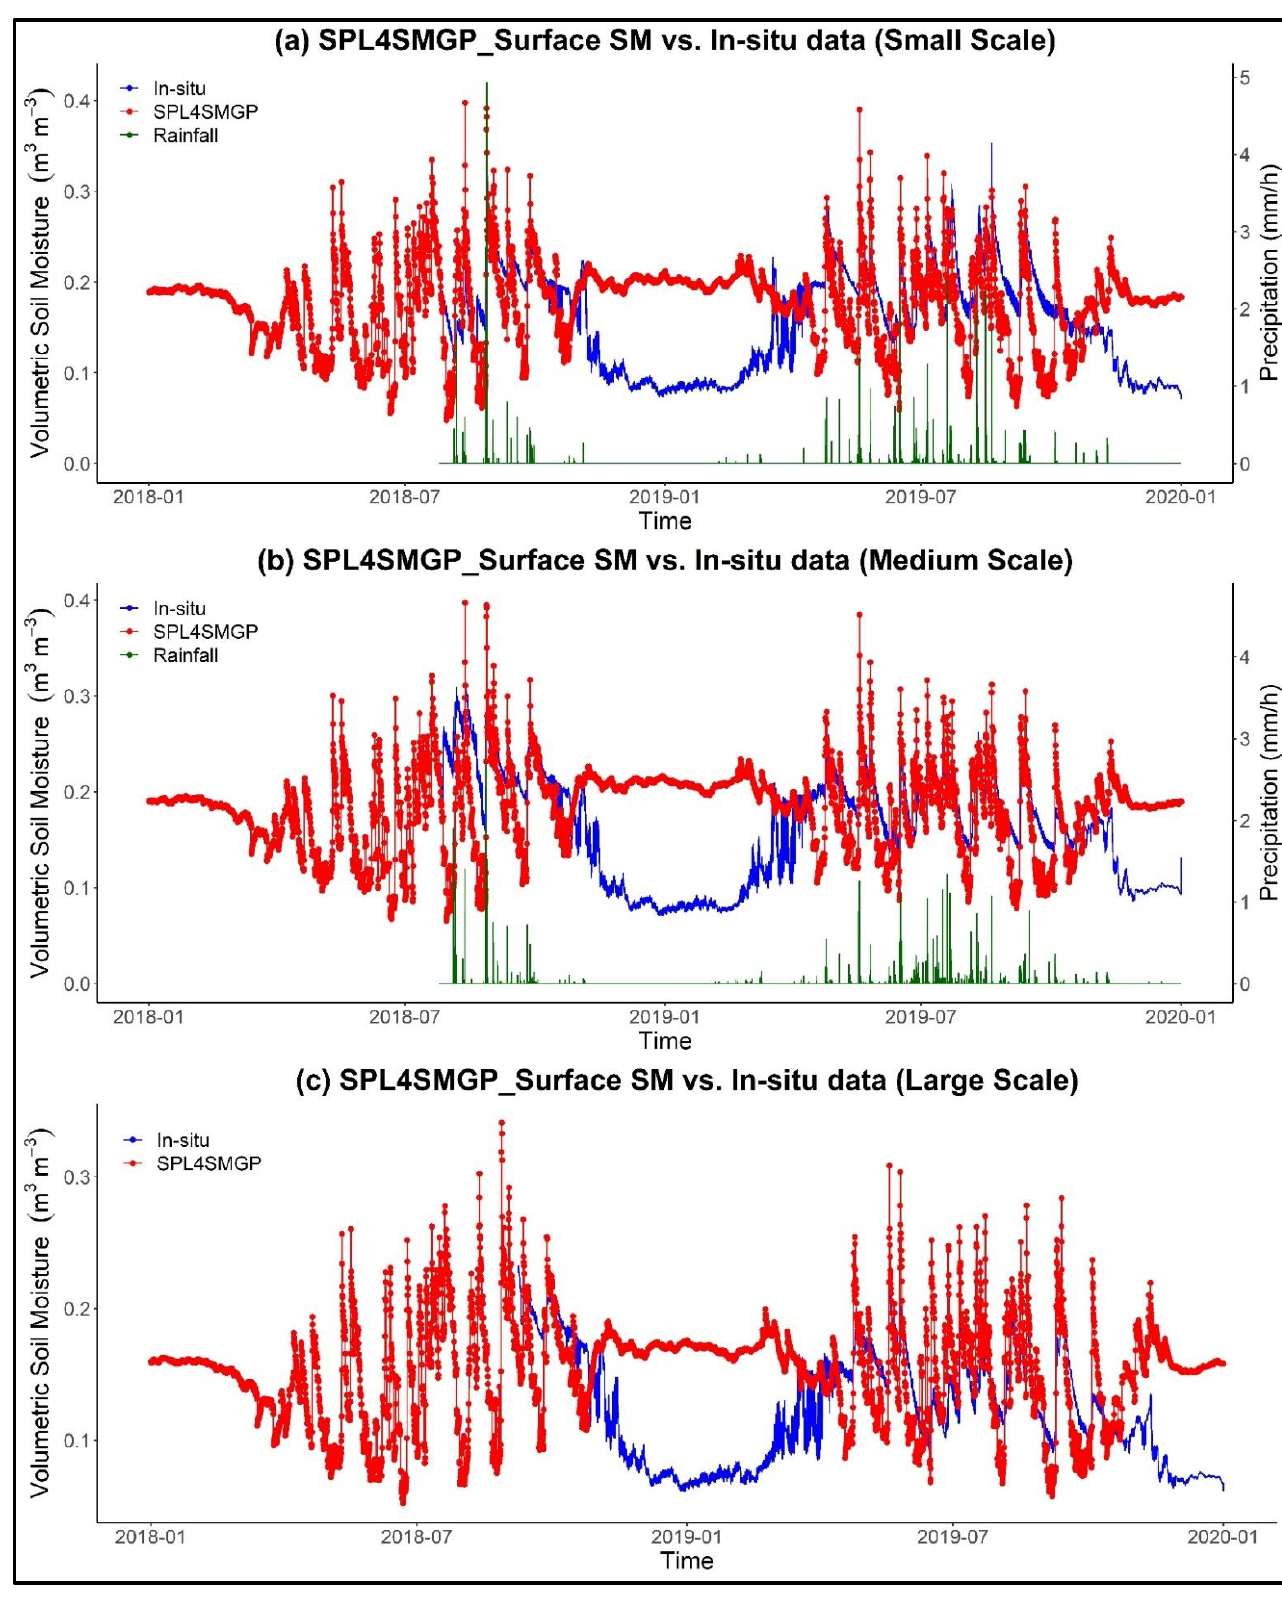
Figure 2. Time series evaluation of SPL4SMGP SSM and station averaged in situ SM at different spatial locations, ( a ) S-scale stations, ( b ) M-scale stations, ( c ) L-scale stations.